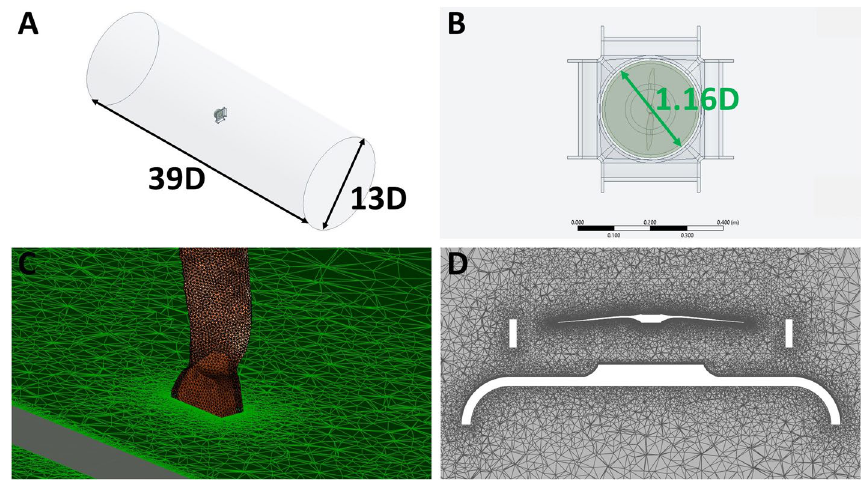
Fig. 5 A Dimensions of stationary domain, B diameter of frozen region, C meshes near propeller surface, and D cross-sectional mesh plane for second fluid domain